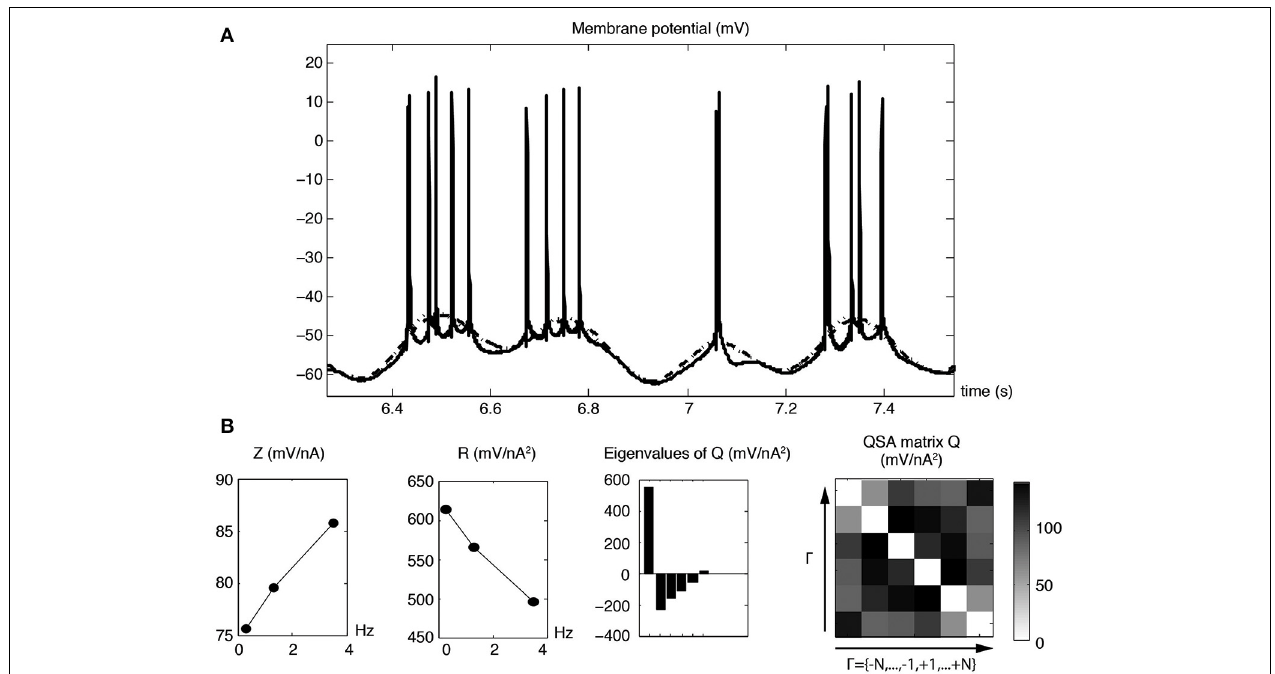
FIGURE 11 | Linear and quadratic membrane potential responses for pre-resonance stimulation frequencies ( f 1 = 0 . 3, f 2 = 1 . 3 and f 3 = 3 . 5Hz). (A) Membrane potential responses (solid line) with modulated action potential responses. The dashed and dotted curves show the linear and quadratic